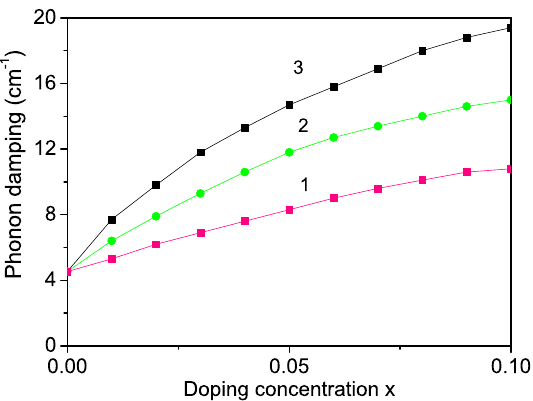
Figure 9. Ion-doping concentration dependence of the phonon damping γ of a MgO NP, d = 20 nm, for T = 20 K and different ions: (1) Sr with R d = 0.8 R b ; (2) Fe, R d = 1.2 R b ; (3) Co, R d = 1.4 R b